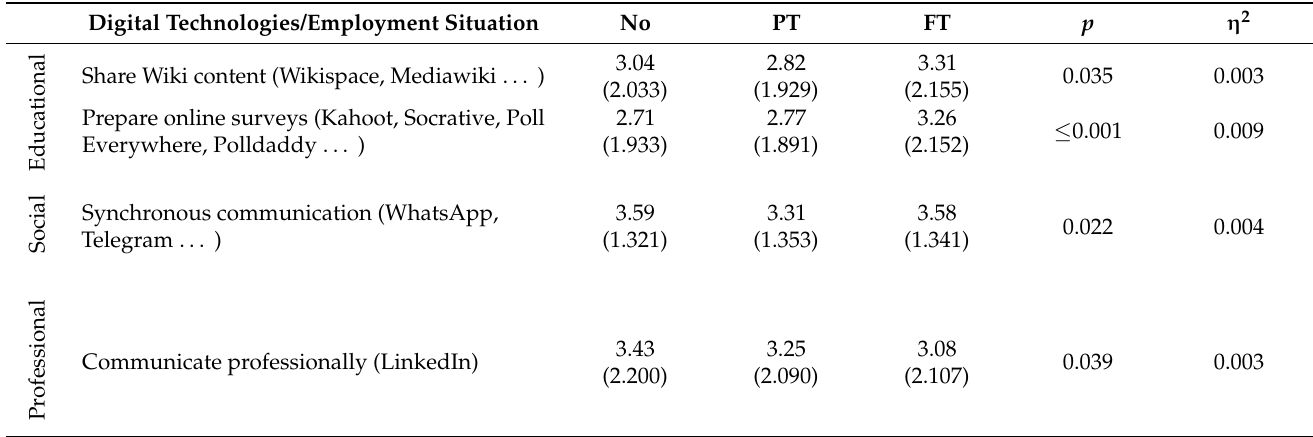
Table 7. Duration of use according to the employment situation (no work, part time PT, full time FT) as a fixed